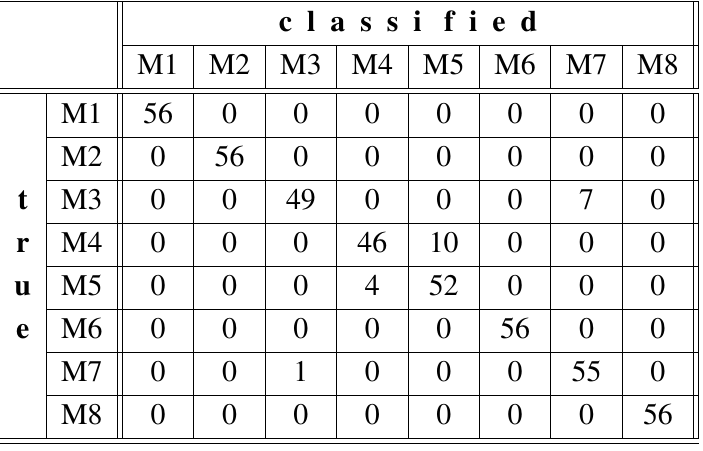
Table 8. Confusion matrix for LSM (LOO cross validation,